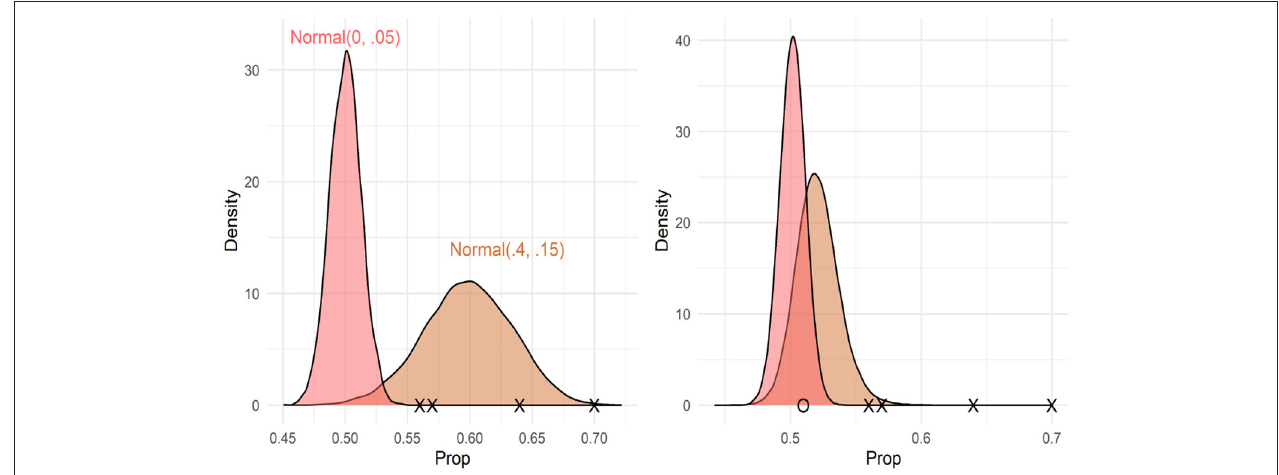
FIGURE 4 | Prior (left pane) and posterior (right pane) distributions for Bayes factor analyses using Normal (0.4, 0.15) as the prior distribution. Xs represent the sample means from Gertner et al. (2006), and O (right pane only) represents the sample mean from this study. The Bayes factor comparing these models supported the null (BF =